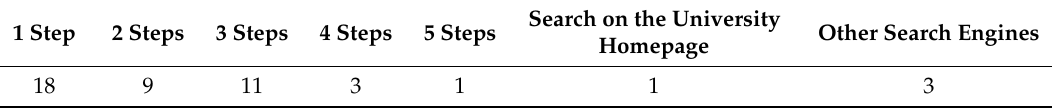
Table 1. Accessibility of information concerning the existence / functioning of an in-house press.